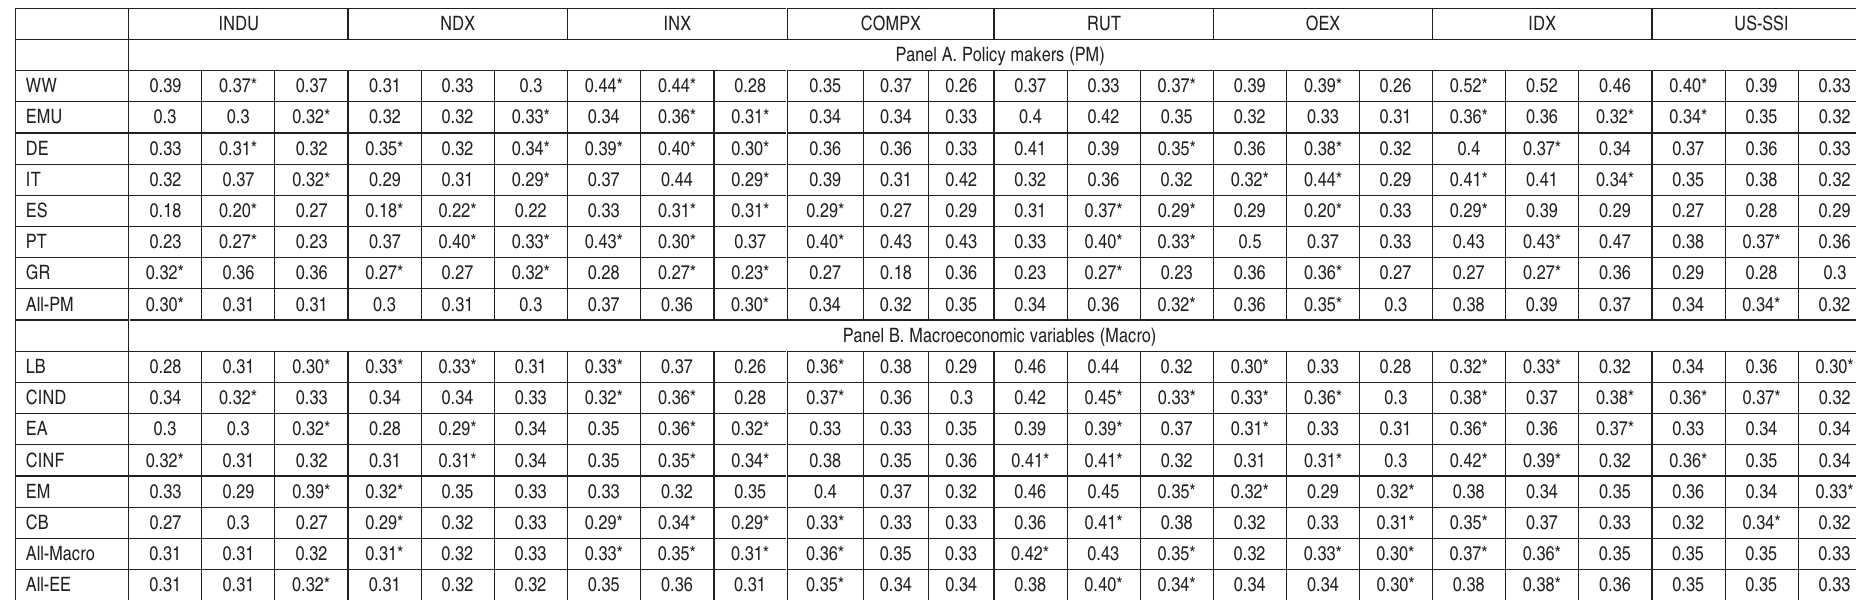
Table 7. Jump magnitude - US stock spot indices (US-SSI)